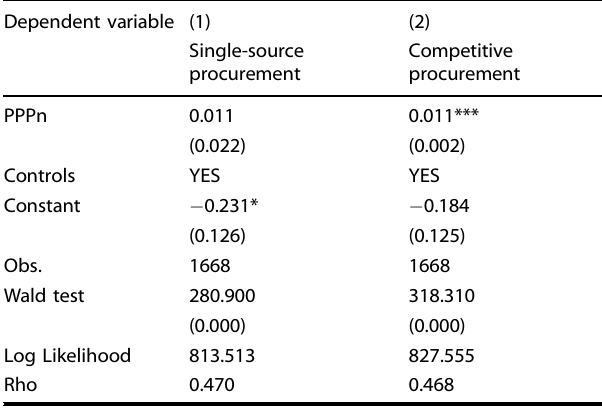
Table 5. Effect of the procurement mechanism.